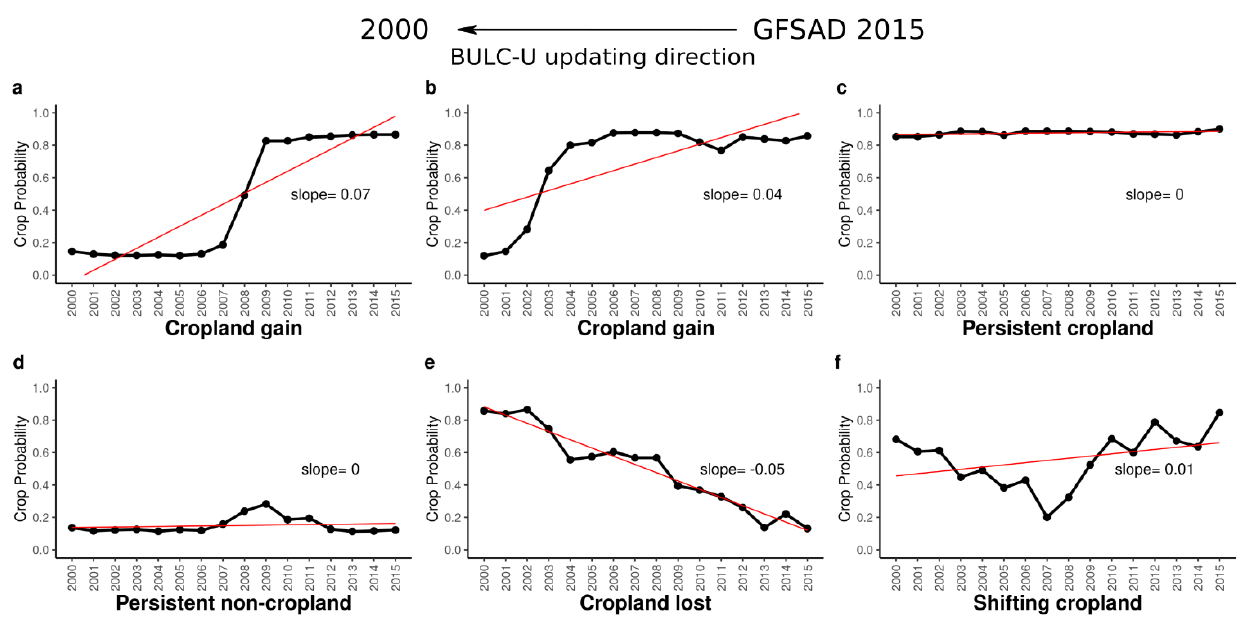
Figure 3. The crop class probability slope trend (black dots and line) fitted with a simple linear regression (red line) for cropland gain ( a , b ), persistent cropland ( c ), and persistent non-cropland ( d ), crop abandonment ( e ), and intermittent cropland ( f ).